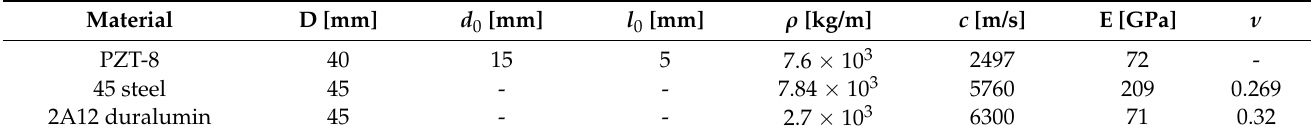
Table 1. Material parameters of the ultrasonic transducer.